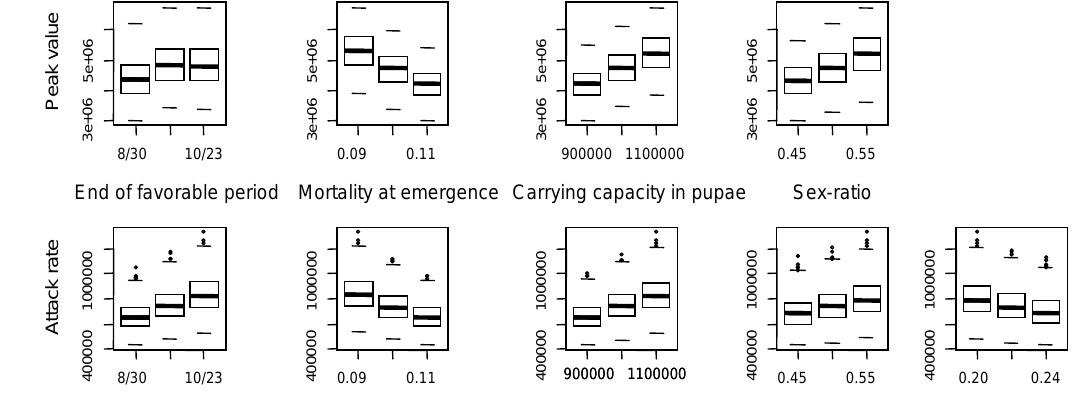
Figure 6. Variations of model outputs (in lines) with parameters contributing to more than 10% of their variance (in columns): 3 levels were tested per factor (nominal value ±10%). For each considered parameter and model output, a box-and-whisker diagram graphically depicts the maximum, minimum, median, lower and upper quartiles values of the model output obtained from the simulations with three different levels of the parameter